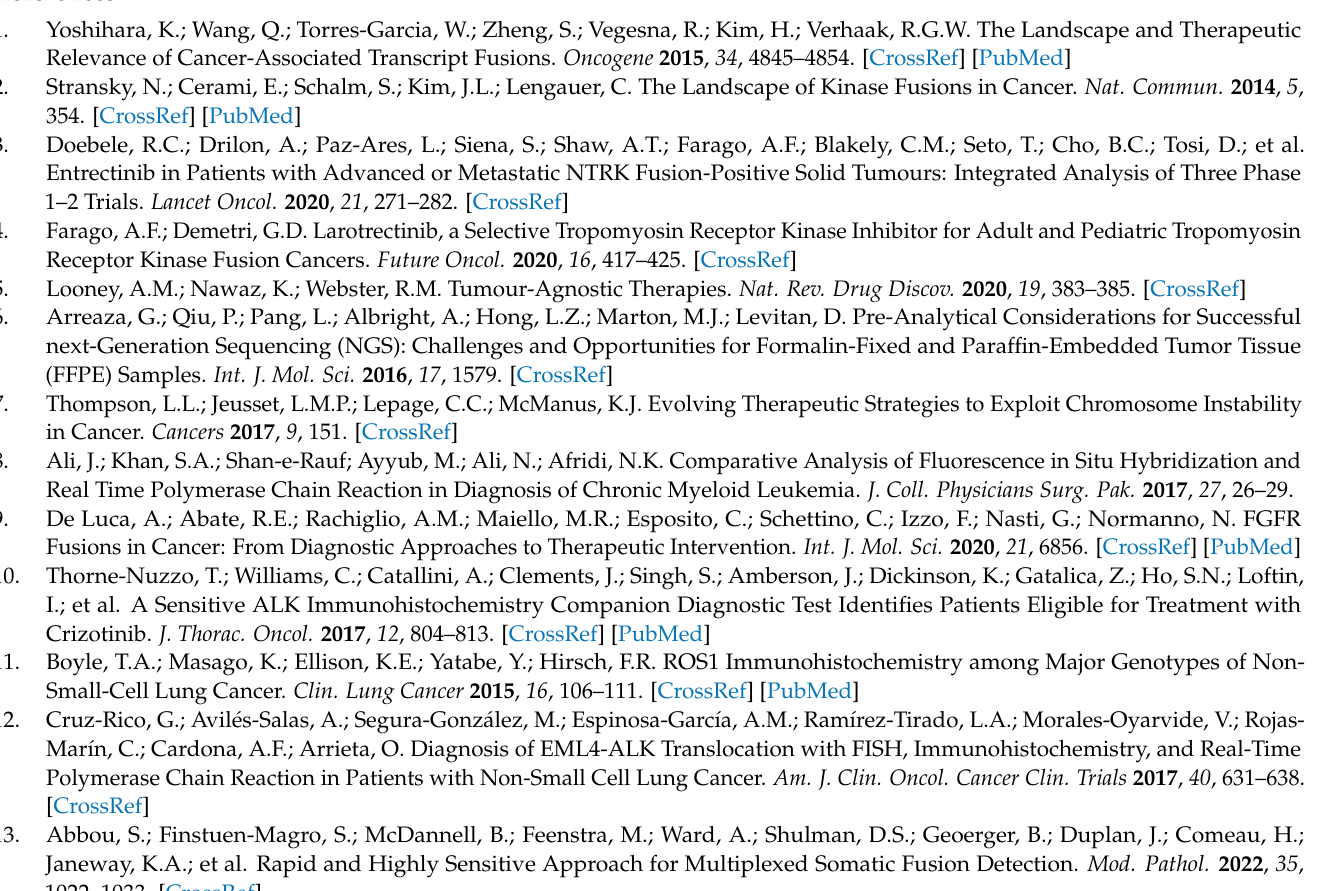
Table S2: The description of patients biosamples in experimental dataset; Table S3: Oligonucleotide RT-PCR primer sequences; Table S4: TRK chimeric reads found by primary STAR-Fusion